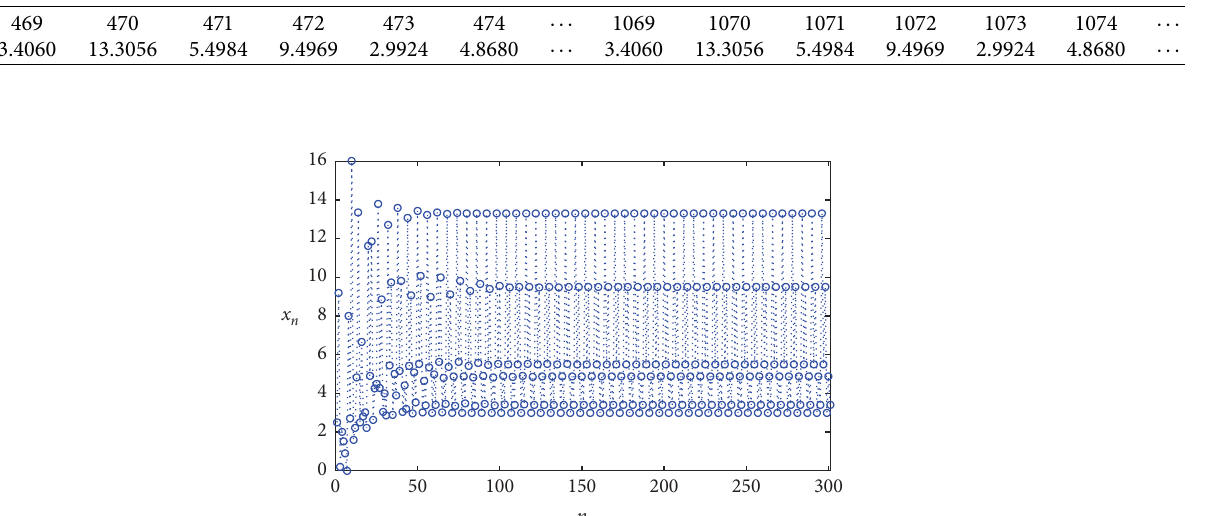
Table 1: Te partial value of the solution of equation (25) with the initial values (26).